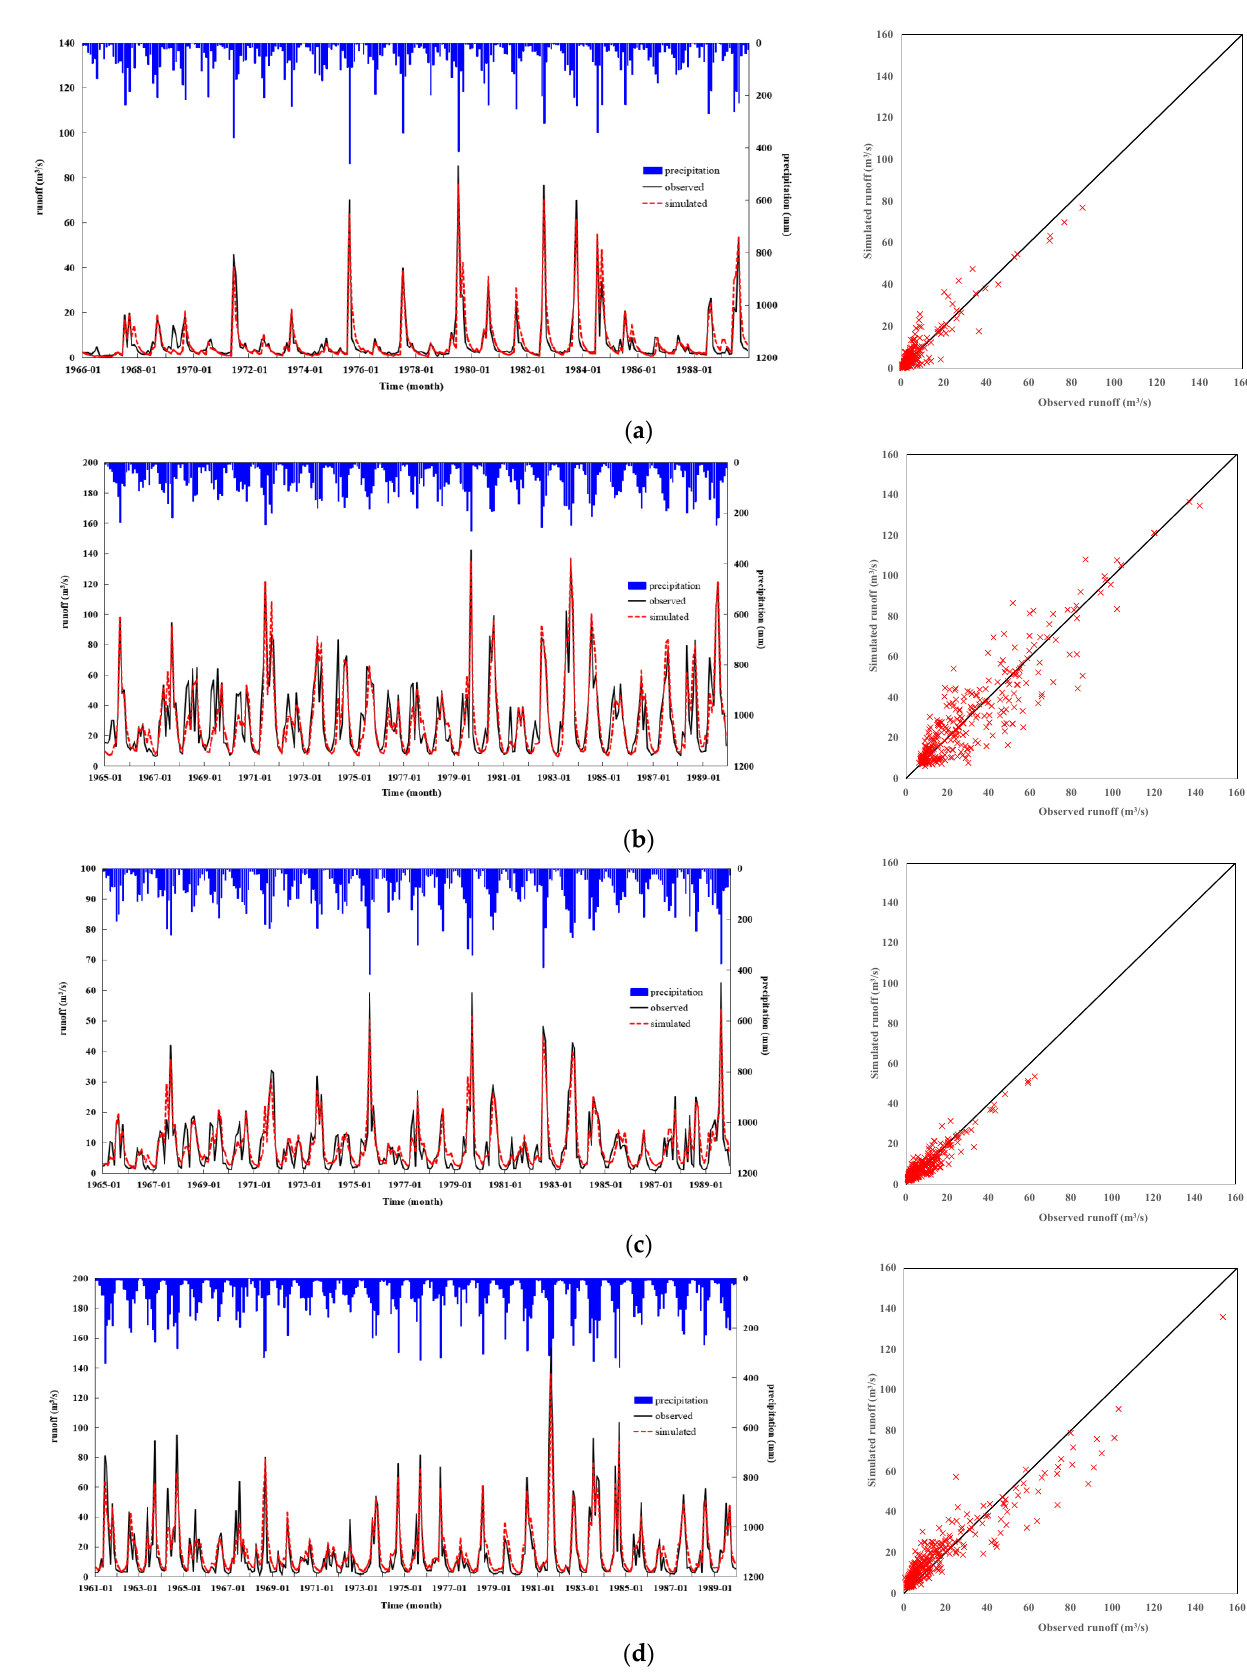
Figure 3. Observed and simulated monthly runoff hydrographs at: ( a ) Sheqi; ( b ) Taikou; ( c ) Wanyugou; ( d ) Youshuijie.